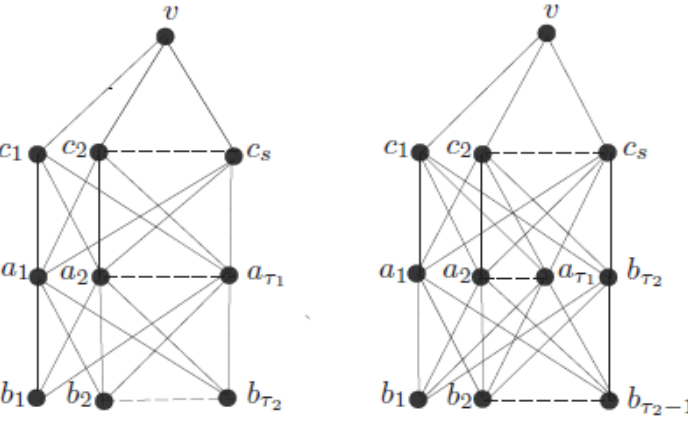
Figure 2. Networks ℵ and ℵ ∗